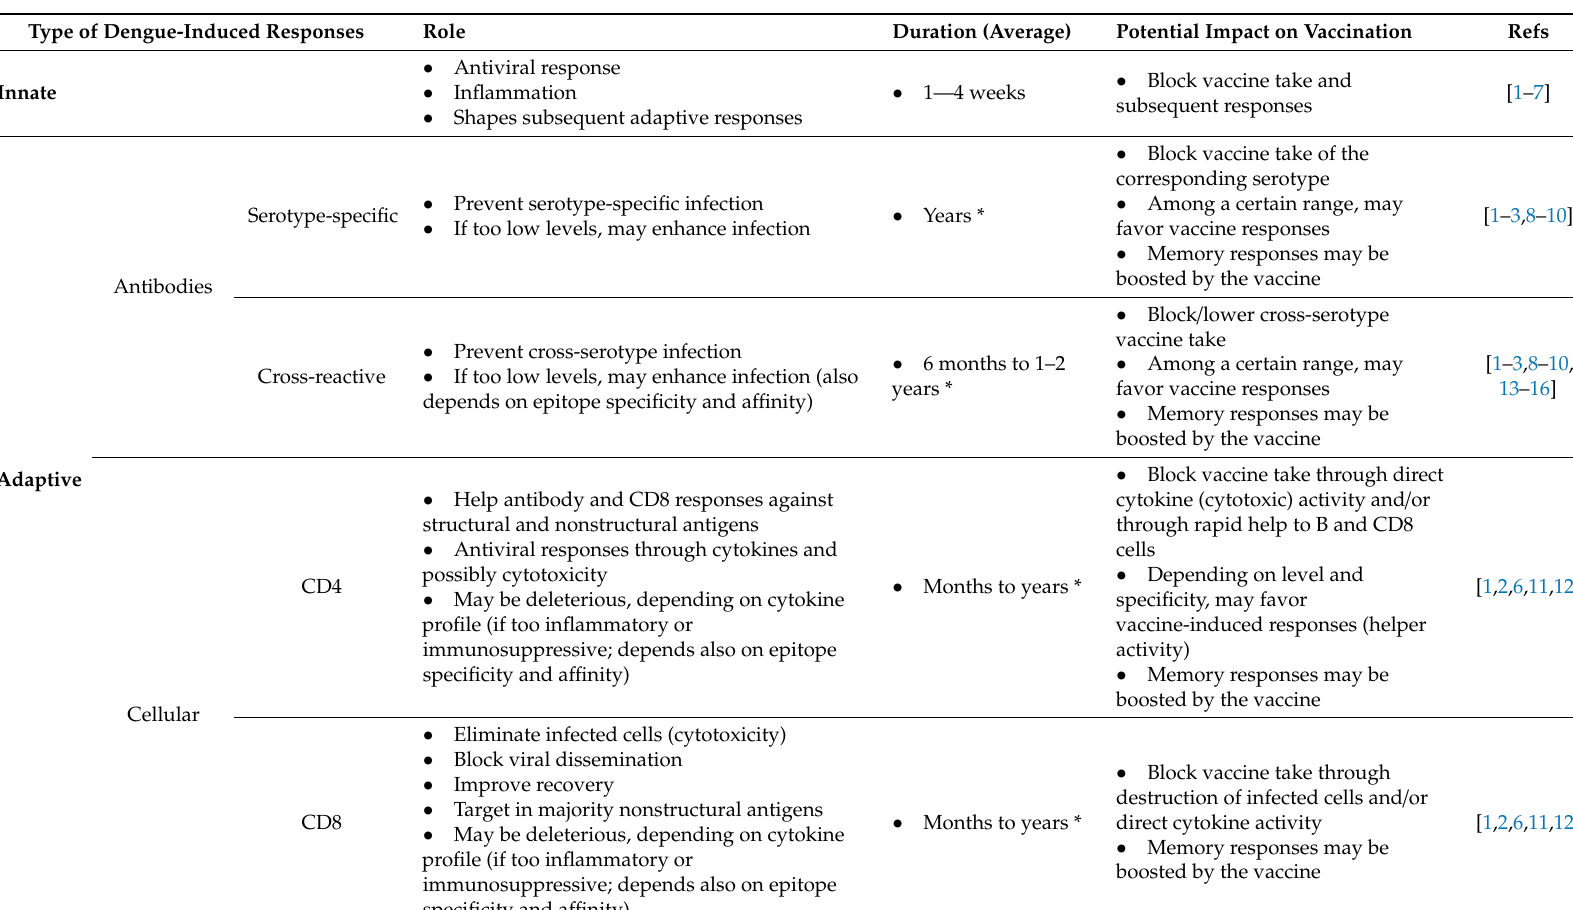
Table 1. Synthetic view of the di ff erent types of responses induced after wild-type dengue infection, and of their potential impact on subsequent live vaccination. Duration of such responses is only indicative and depend on multiple host and viral parameters. Antigen and epitope specificity may also depend on the considered serotype for both B and T cell responses. The level and nature of responses also depend on the primary or post-primary nature of viral infection. *: existence of B and T cell